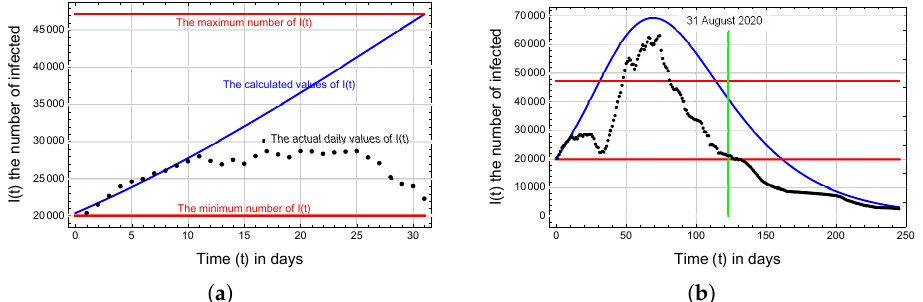
Figure 4. The behavior of the active daily infected cases due to parameter determined from the data of May. ( a ) Calculated and actual active daily infected cases along small period of time (May). ( b ) Calculated and actual active daily infected cases along long period of time (from May to end of